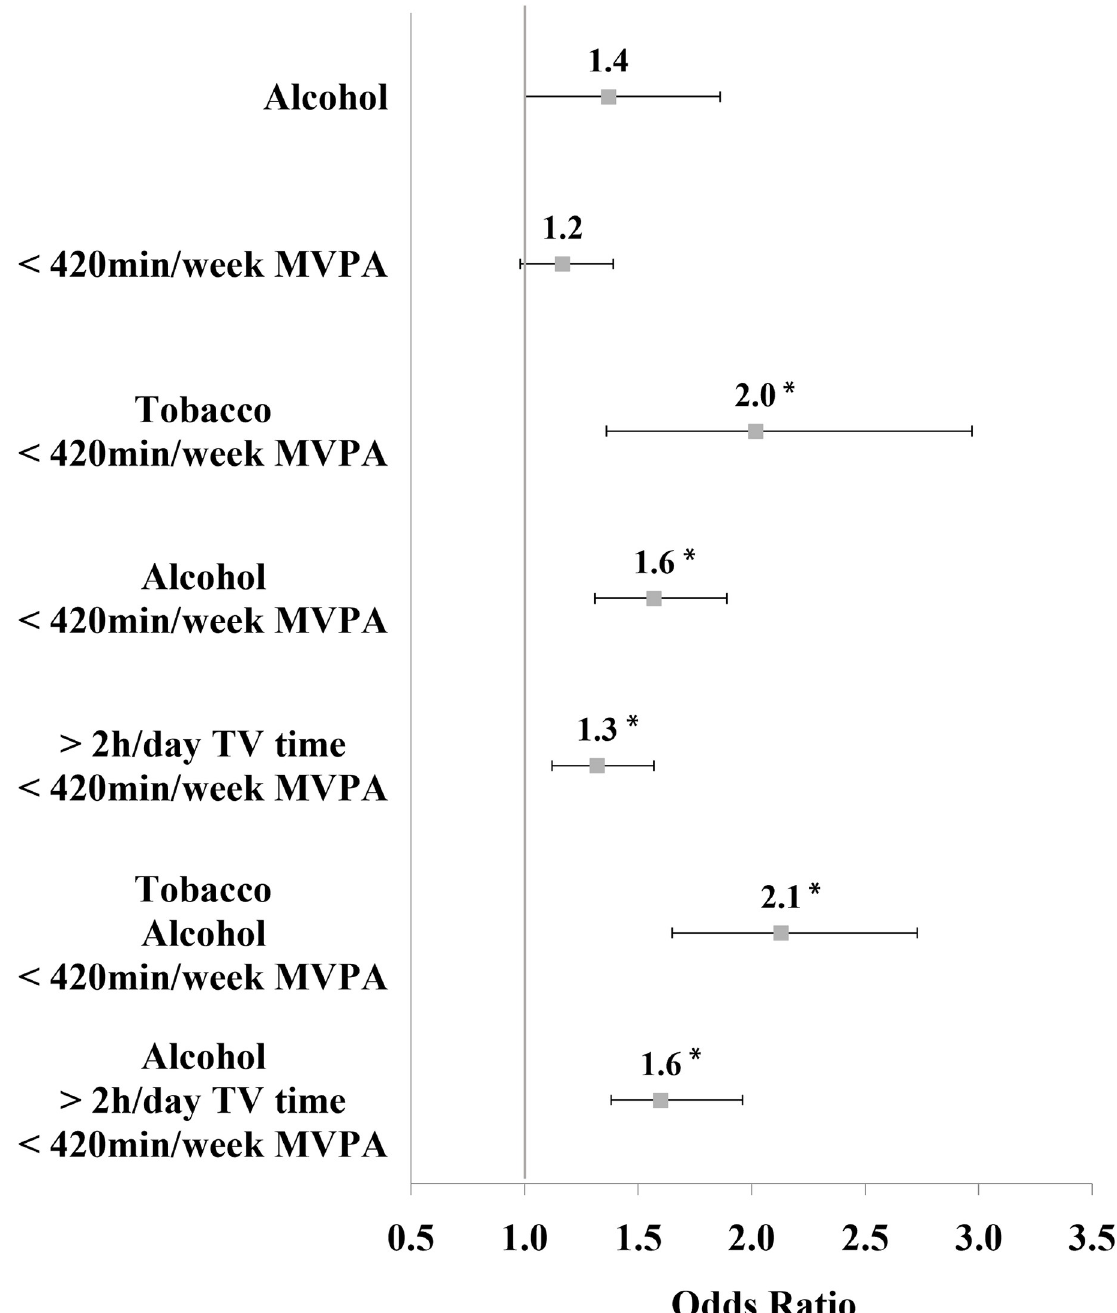
Fig 1. Association of simultaneity of health-risk behaviours with worse self-rated health in Brazilian adolescents. National Adolescent School-based Health Survey 2015 (PeNSE). Note: Category "no risk behaviours" was used as a referent; MVPA: Moderate to vigorous physical activity; Odds ratio is adjusted for sex, age and maternal education. � : Represents a statistically significant p-value < 0.003.